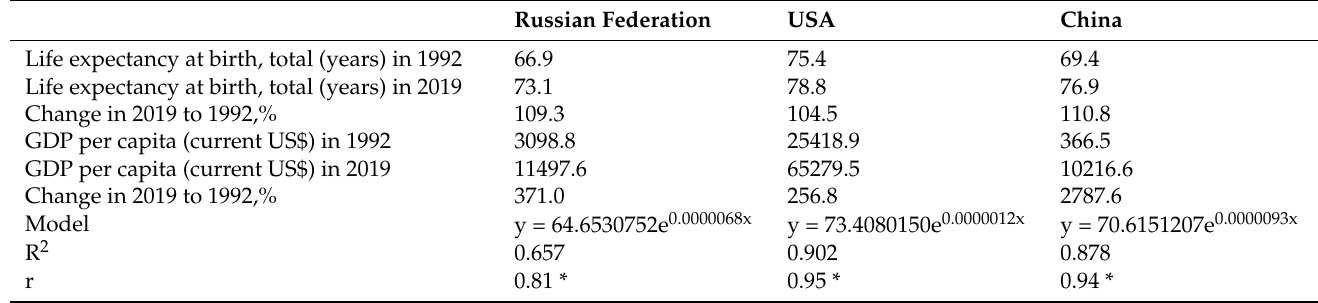
Table 5. Models of the dependence of life expectancy in the Russian Federation, the United States, and China on the level of GDP per capita for the period of